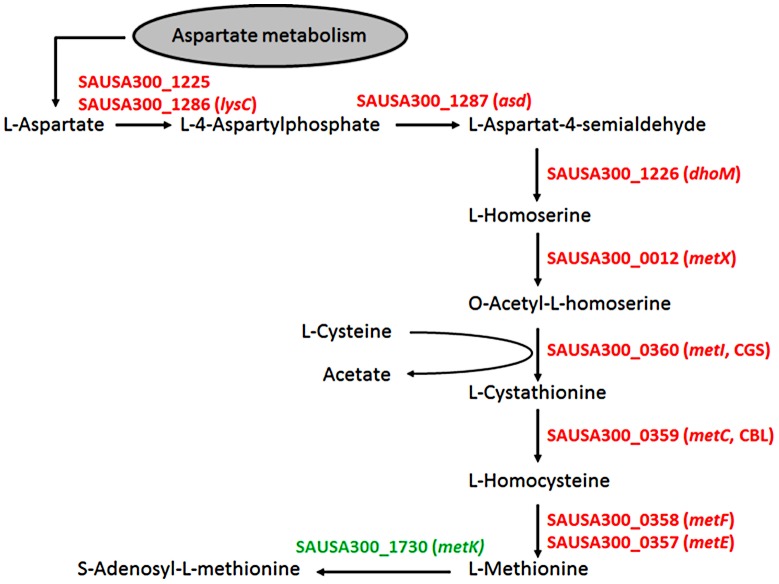
Schematic representation of the methionine-biosynthetic pathway of S. aureus USA300 (adapted from KEGG pathway database).All genes shown in red were up-regulated in SNM3 compared to BM as determined by microarray analysis, with SAUSA300_0357 to SAUSA300_0360 exhibiting the strongest effects (13 to 32-fold). The metK gene, shown in green, was expressed at similar levels in BM and SNM3. The cystathionine-γ-synthase (MetI) represents the target for DL-propargylglycin.